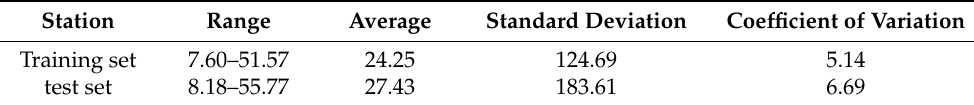
Table 6. Statistical characteristics of the data used.